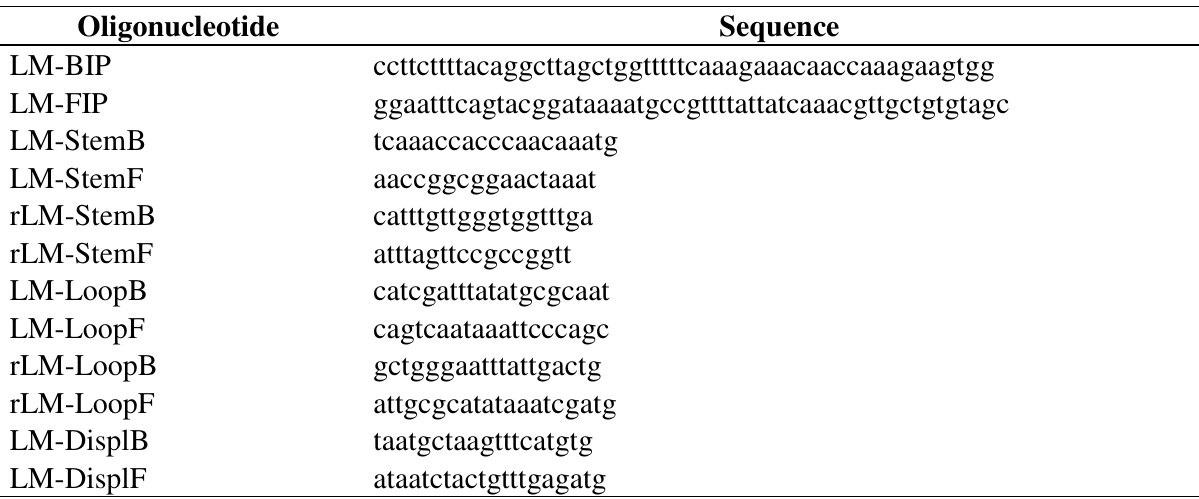
Table 3. Sequences of oligonucleotides designed for Listeria monocytogenes internalin A.